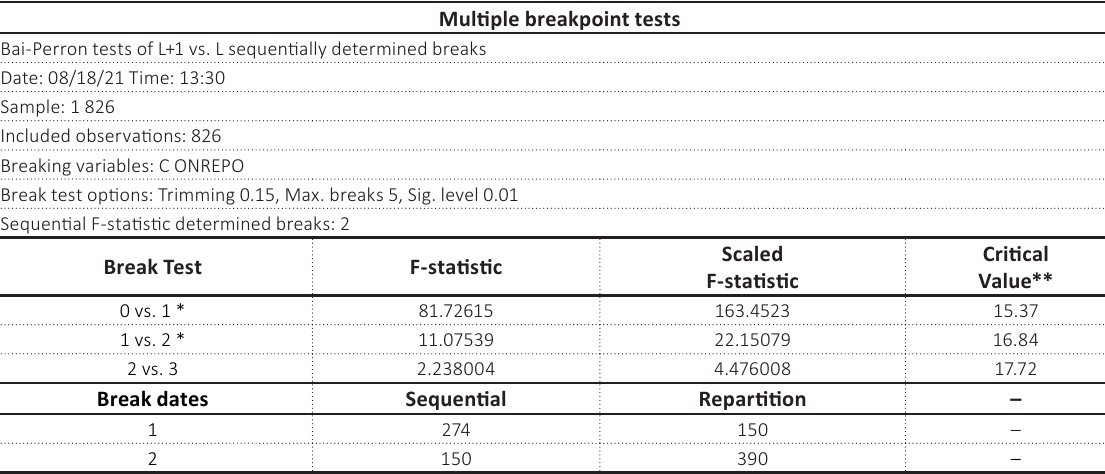
Table 2. Sequential segmentation of net aggregate demand for liquidity in Hungary Multiple breakpoint